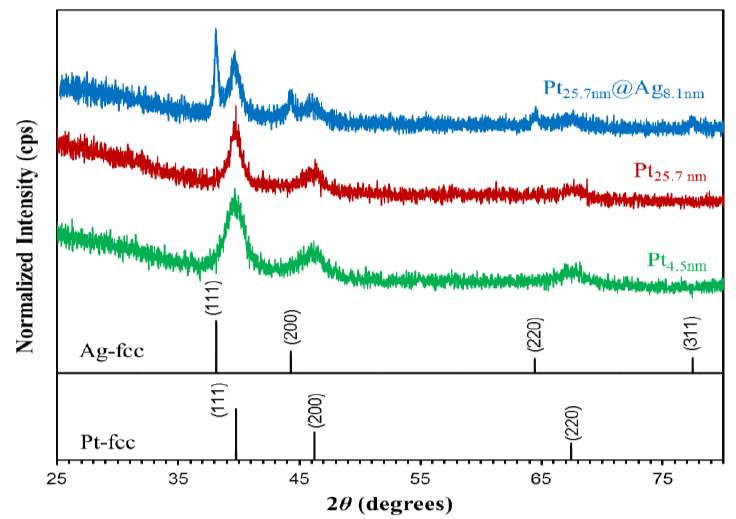
Figure 5. XRD pattern of platinum seeds (4.5 nm), platinum NPs (25.7 nm) and Pt @Ag NPs. The reference peak positions for fcc phase platinum and silver are 25.7 8.1 also